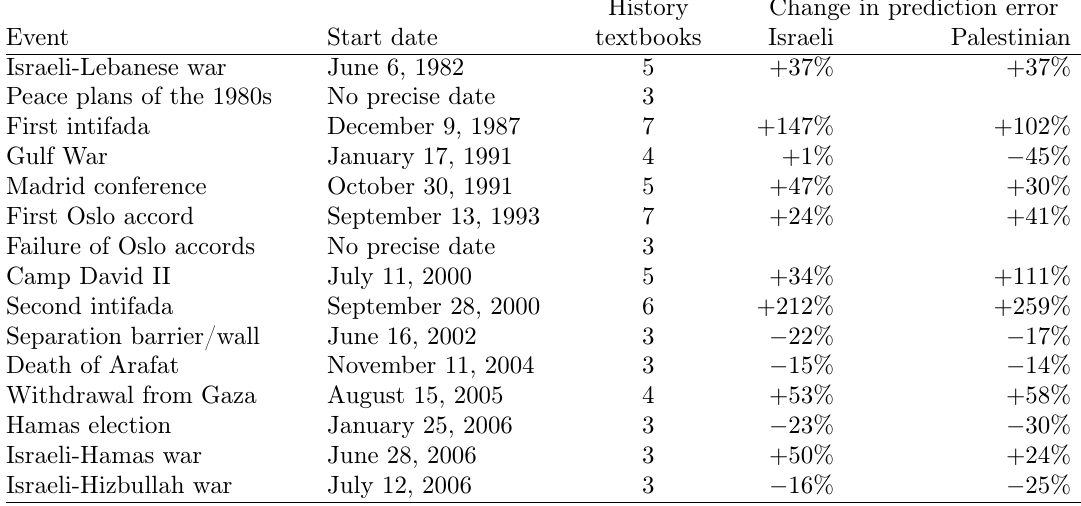
Note: Shaded cells indicate increases in the root mean squared error (RMSE) in the 90 days following the onset of a major historic event, compared with the prediction error in the preceding 90